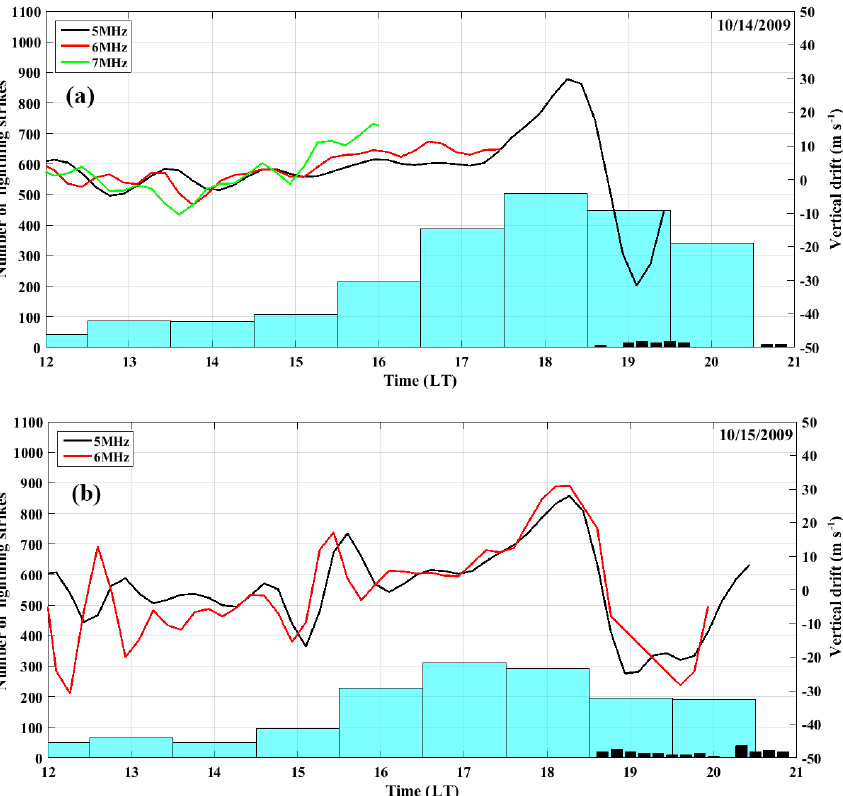
Figure 8. Vertical drift (colored lines), lightning strike activity (cyan bars) and the range of spread F, Q f (black bars), for 14 October 2009 (a) and 15 October 2009 (b) .